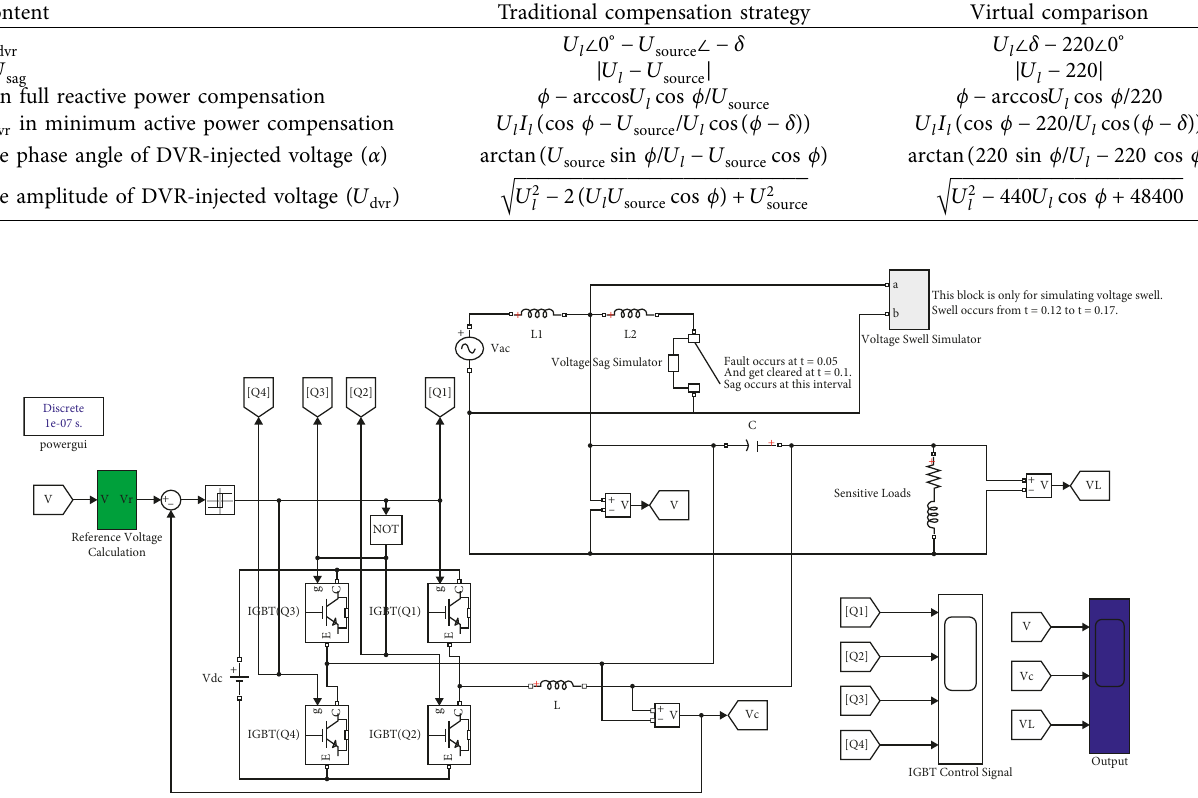
Figure 9: The presentation of the simulation of the DVR